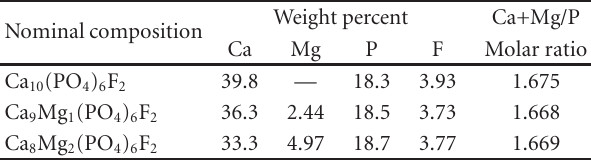
Table 1: Chemical analysis data for as-prepared samples. Nominal